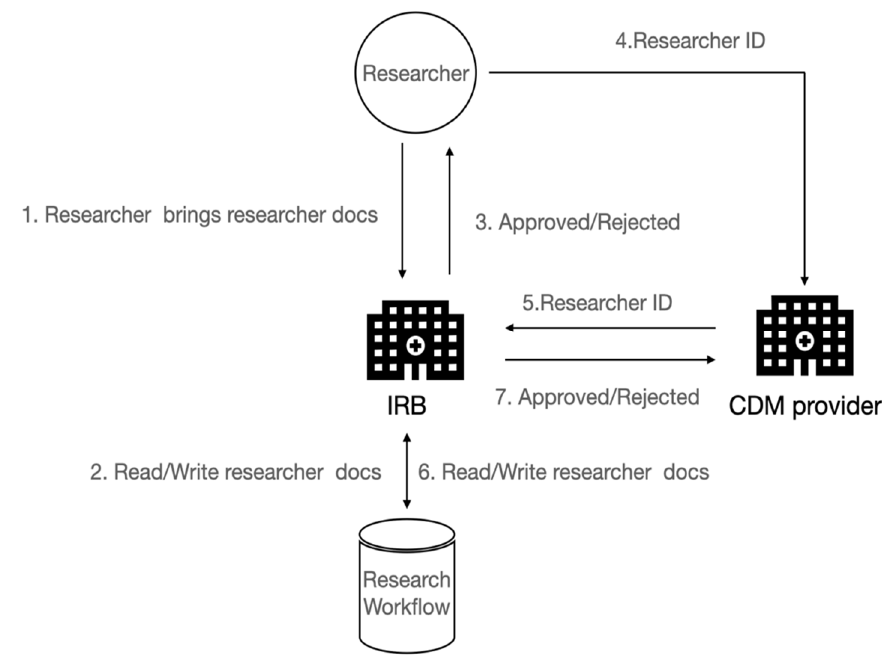
Figure 2. IdM based on a centralized model in the cloud